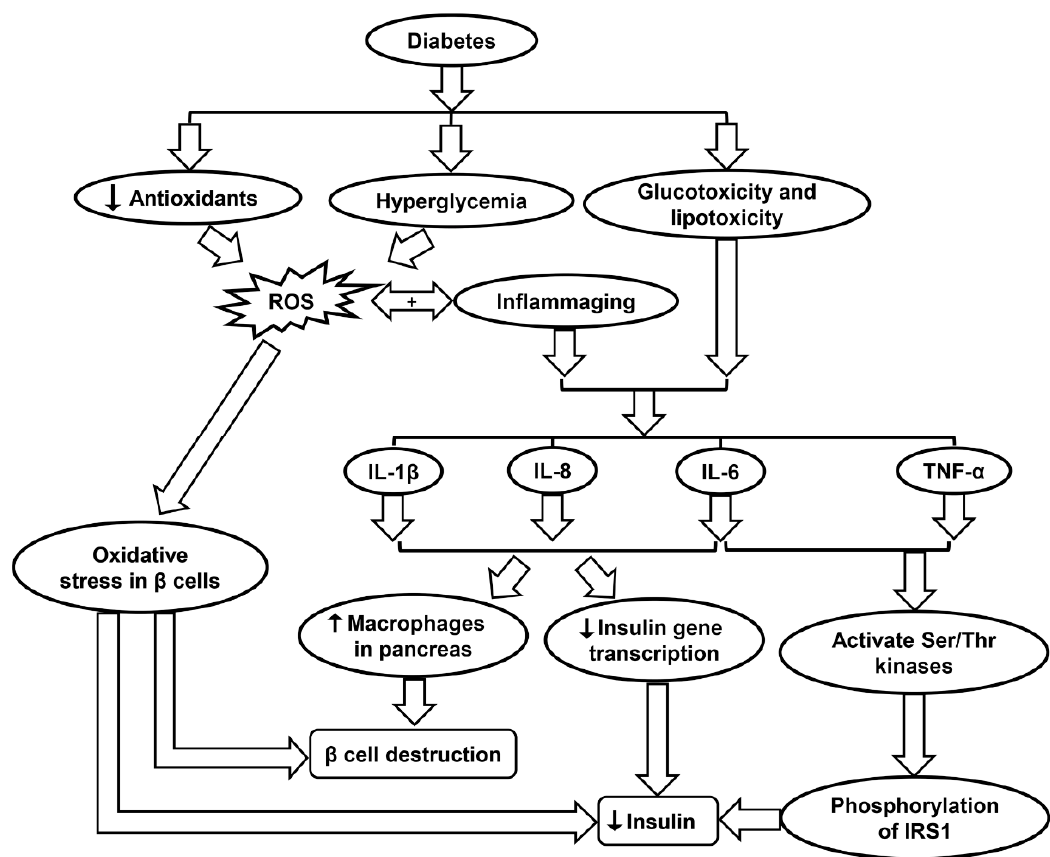
Figure 5. Schematic showing the molecular mechanisms contributing to diabetes progression. IL-1 β , interleukin-1 β ; IL-8, interleukin-8, IL-6, interleukin-6; IRS1, insulin receptor substrate 1; ROS, reactive oxygen species; TNF- α , tumor necrosis factor- α .